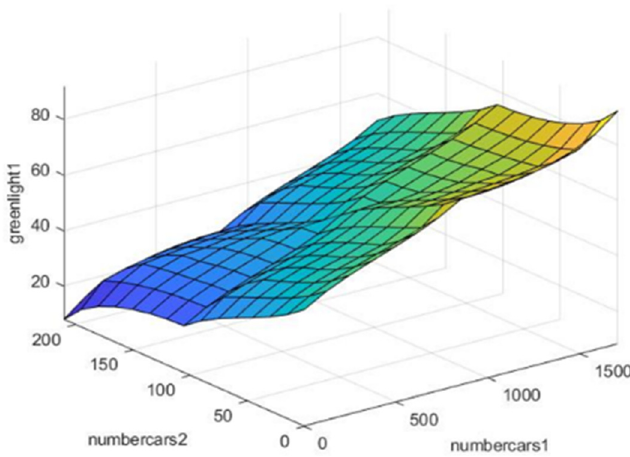
Figure 9. Surface of the fuzzy controller with one output and two inputs for junction 2.